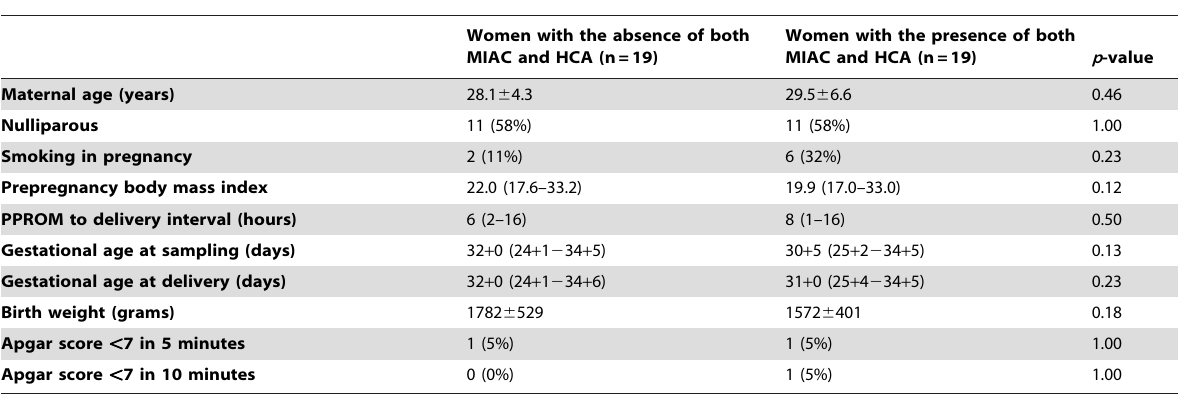
Table 1. Demographic and clinical characteristics of women and newborns involved in the exploratory cohort.